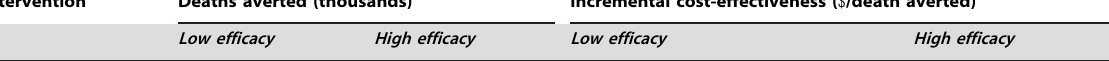
Intervention DALYs averted (millions)